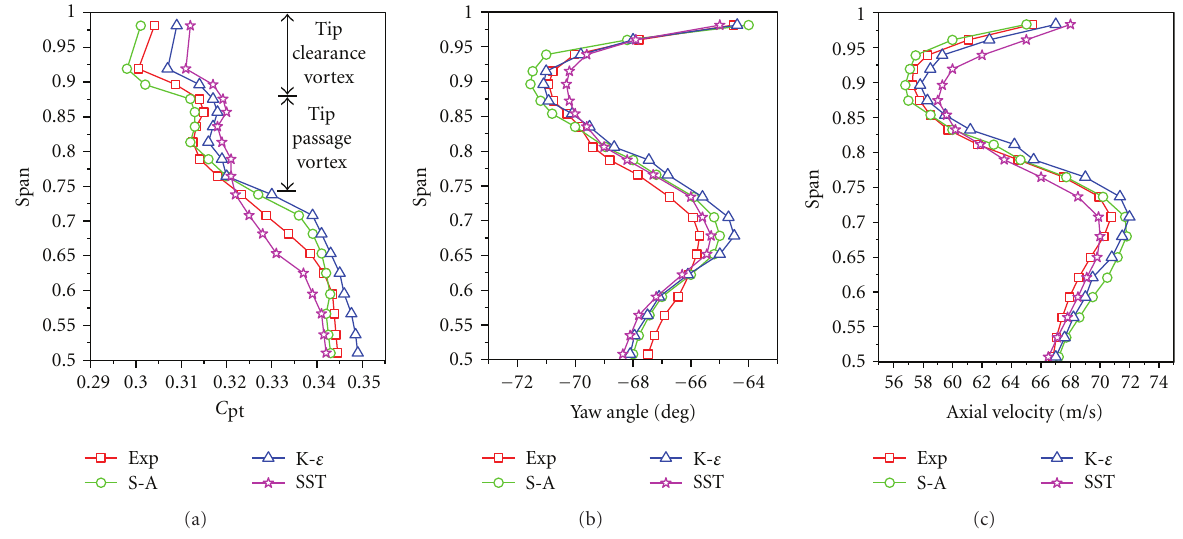
Figure 2: (a) Total pressure coe ffi cient, (b) yaw angle, and (c) axial velocity at rotor exit, pitchwise mass-averaged.